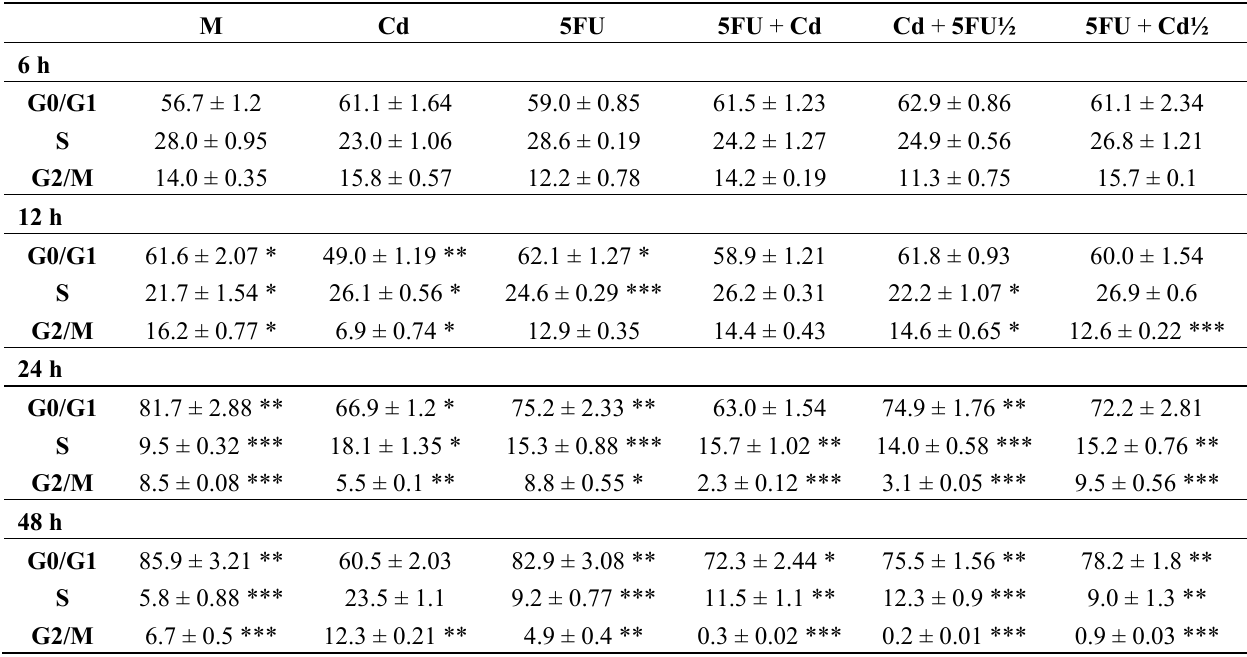
Table 1. Cell cycle distribution induction in the MCF-7 human breast cancer cell line after treatment for 6, 12, 24 or 48 h. Data are expressed as mean of % ± SEM of three independent